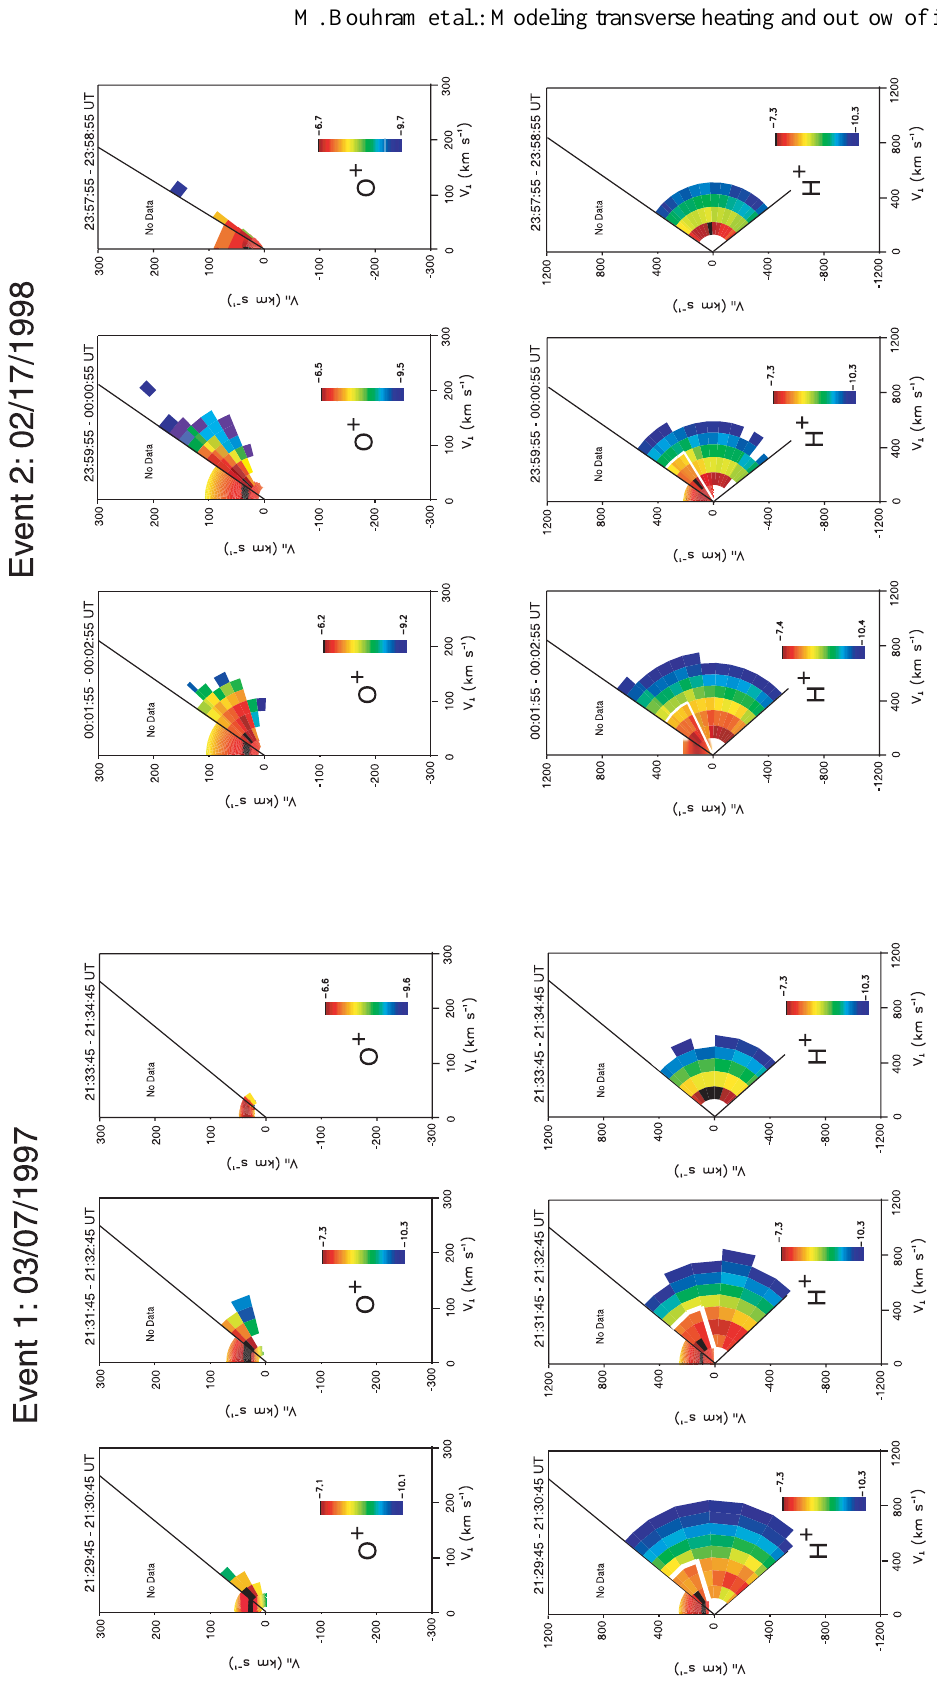
Fig. 5. Ion distribution functions in cm − 3 km − 3 s 3 recorded near the poleward heating boundary during event 1 (left-hand side) and event 2 (right-hand